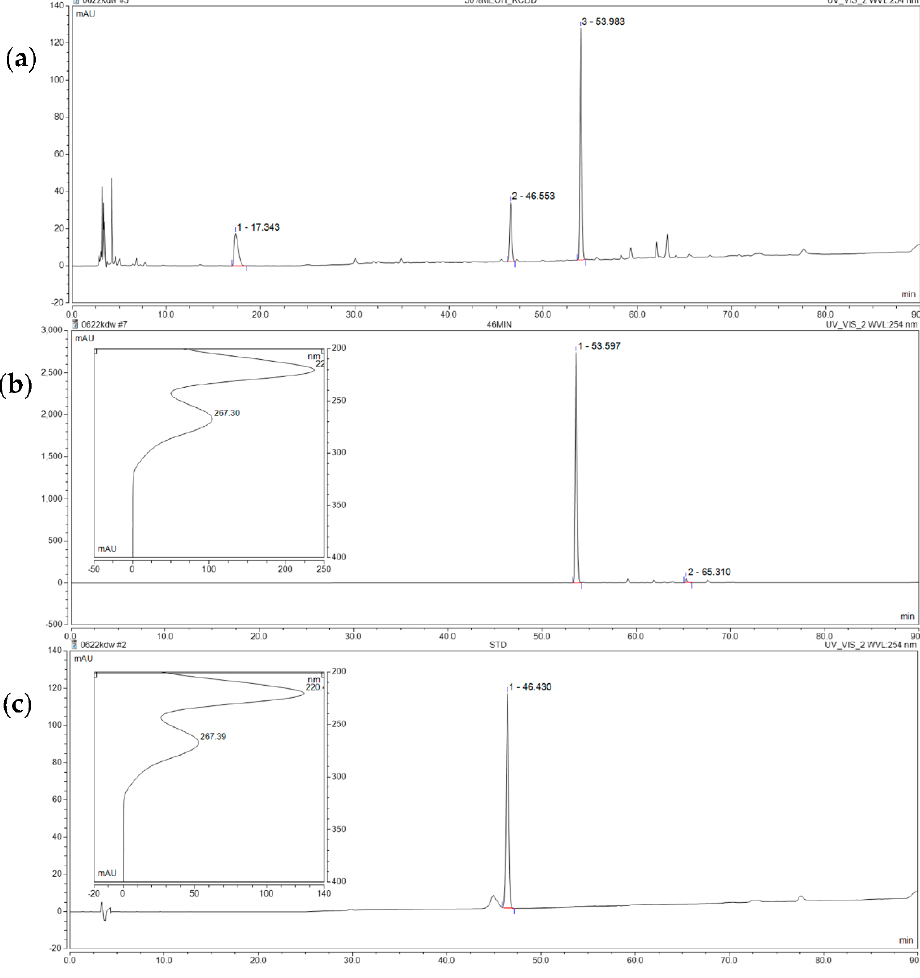
Figure 2. ( a ) High-performance liquid chromatography-photodiode array (HPLC-PDA) chromatogram (detection wavelength, 280 nm) of 50% ( v / v ) aqueous MeOH extract of dried roots of C. ussuriensis . ( b , c ) HPLC chromatogram and UV-Vis spectrum of the major compounds (tang- shenoside I and ussurienoside I with retention of 46.4 min and 53.6 min) with a maximum absorption at 220 nm